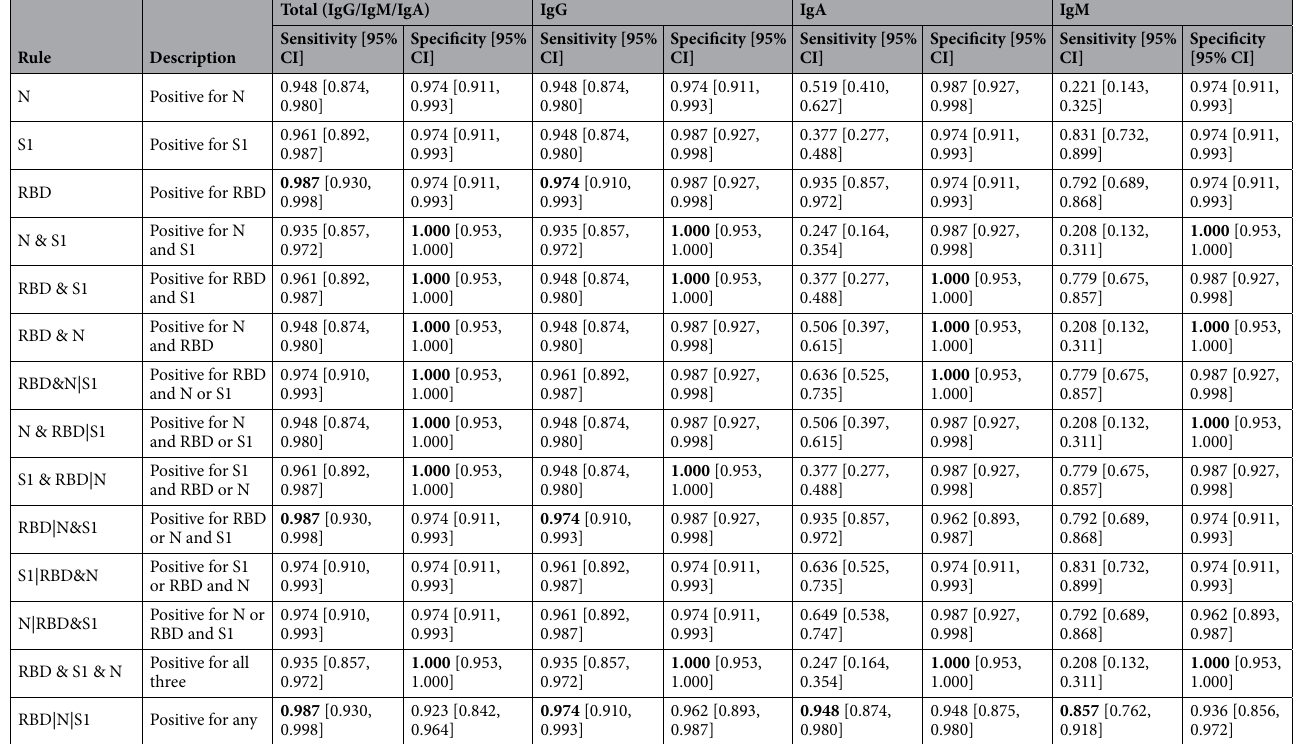
Table 2. Clinical sensitivity and specificity of single-antigen assays and multi-antigen rules. The highest values of each column are highlighted in bold.